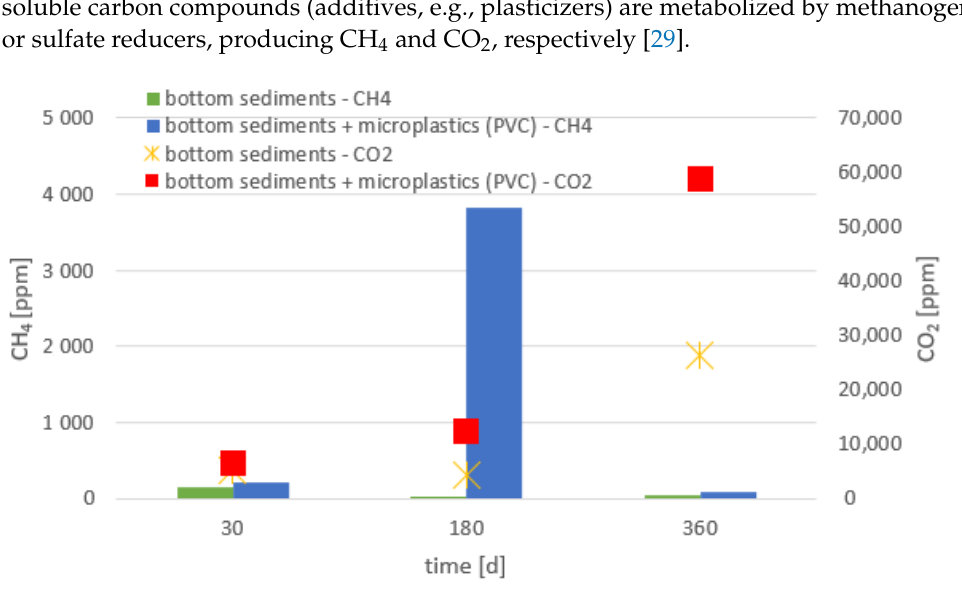
Figure 2. CH 4 and CO 2 emissions from PVC